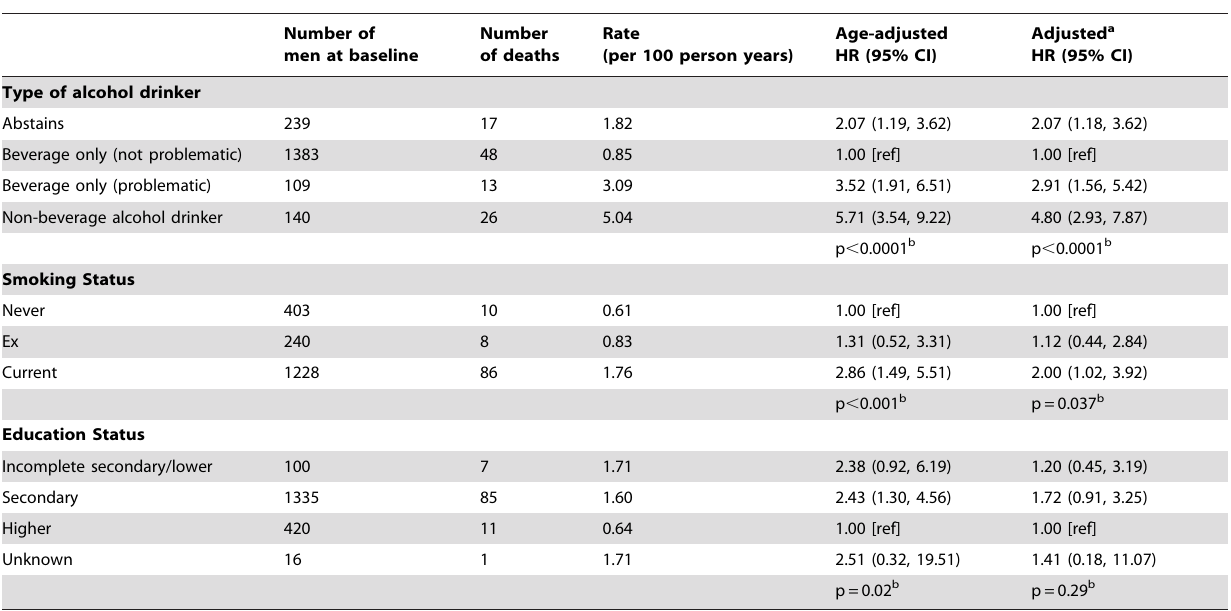
Table 2. Mortality rates and hazard ratios (95% confidence intervals) by proxy reported type of alcohol drinking.